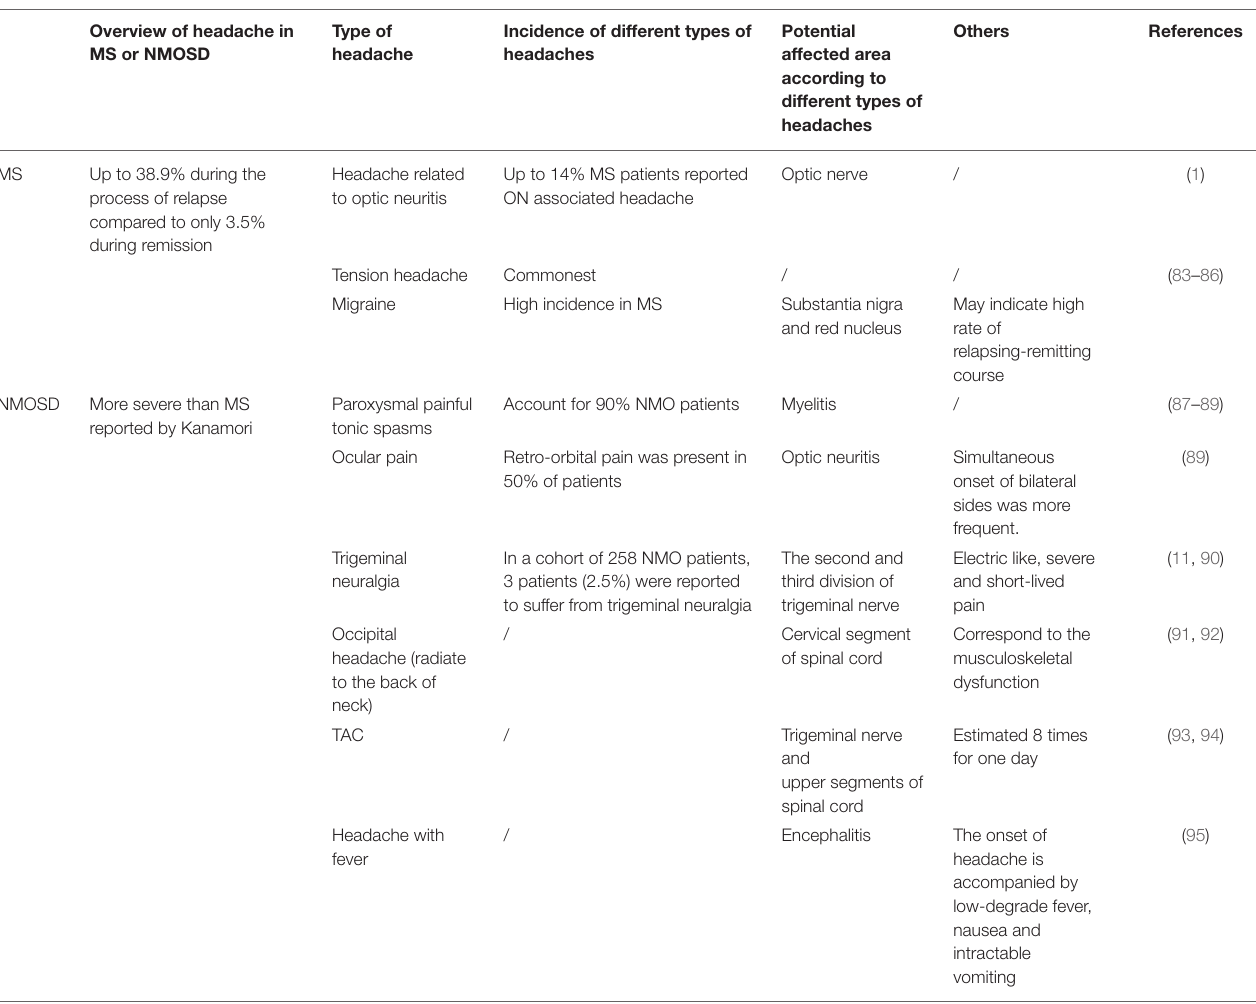
TABLE 5 | Overview of headache in patients with MS or